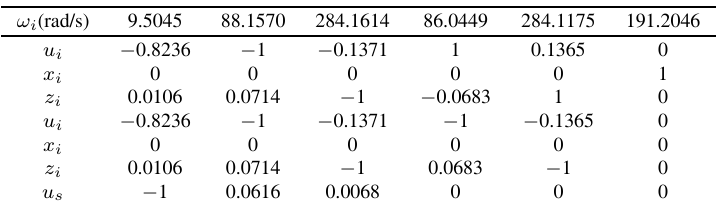
Table 3(a) Modes of the drive system without eccentric center